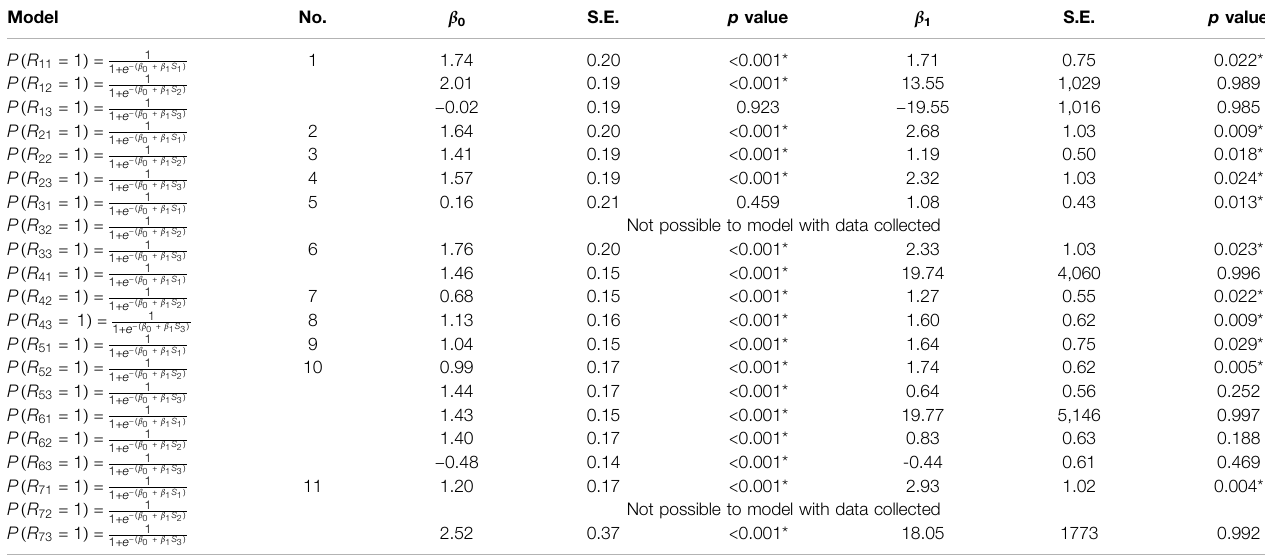
TABLE 5 | Fitted models parameter estimates, standard errors, and p values. Model No. β 0 S.E. p value β 1 S.E. p value P ( R 11 (cid:1) 1 )